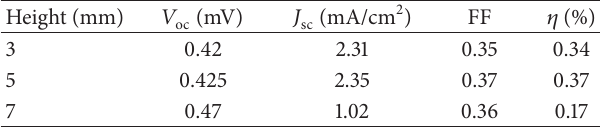
Figure 9: Photovoltaic curves ( J-V ) of the prepared 3D DSSC made by a Pt counter electrode at different cell heights. Table 2: Photovoltaic parameters of the 3D DSSC made by a graphite counter electrode at different cell